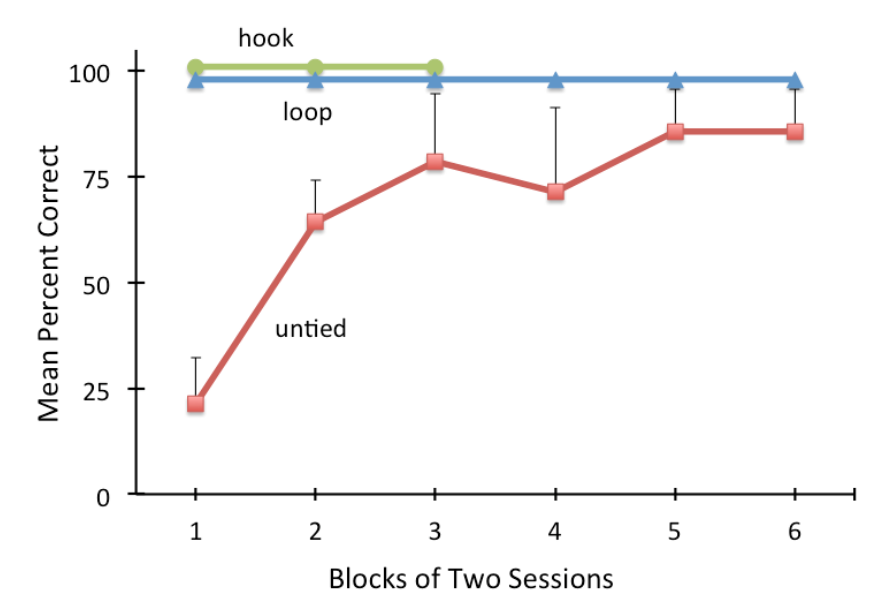
Blocks of Two Sessions for Hook, Loop and Untied